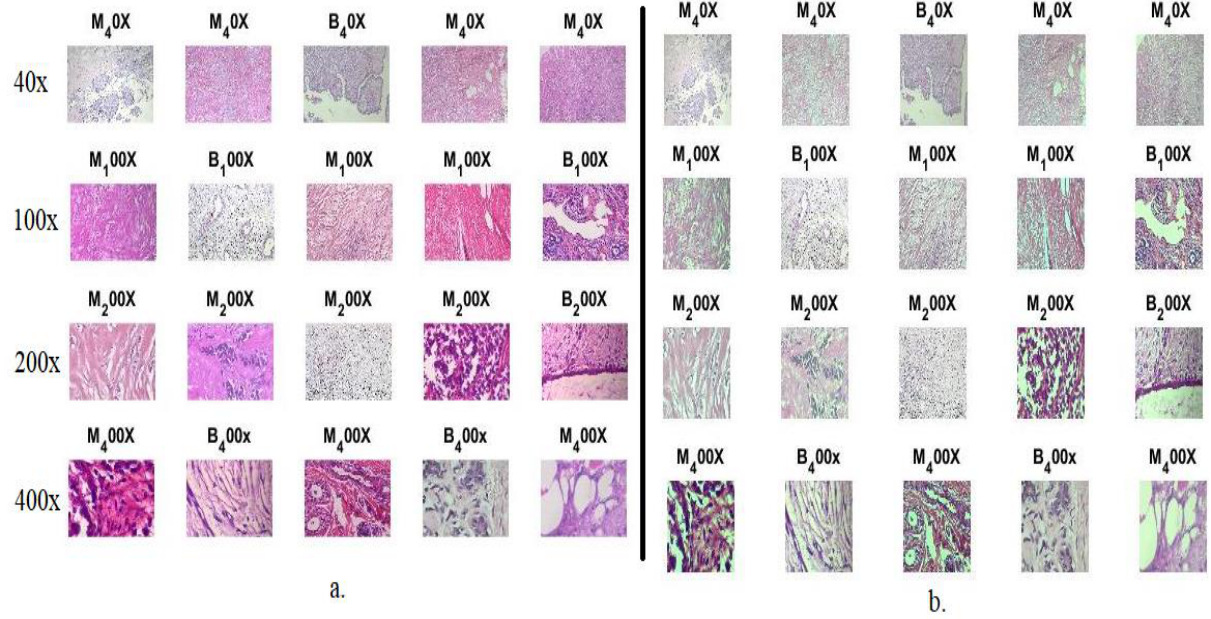
Figure 2. Histological set of images for the BC dataset 40×, 100×, 200×, and 400× ( a ) before enhancement; ( b ) after enhancement.